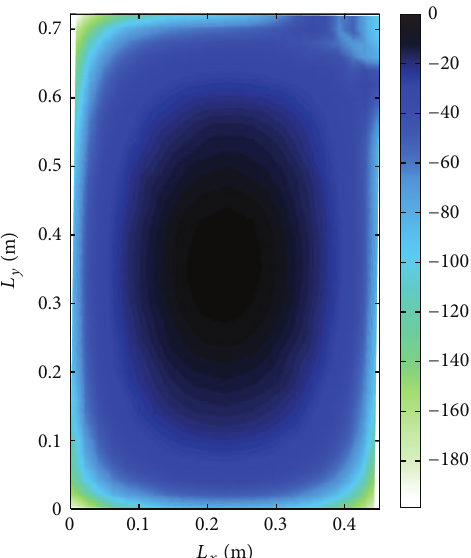
Figure 17: Total WSSG field for the plate excited at the first mode natural frequency, in dB, with the first mode weights (first line of Table